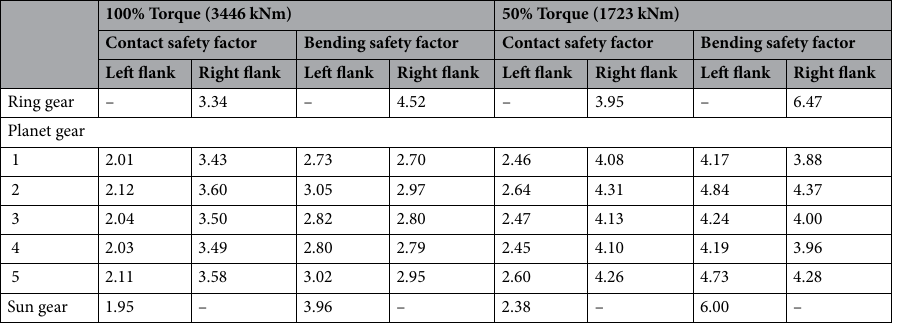
Table 7. Safety factors of the flexible pin model with microgeometry modification under the rated and partial load